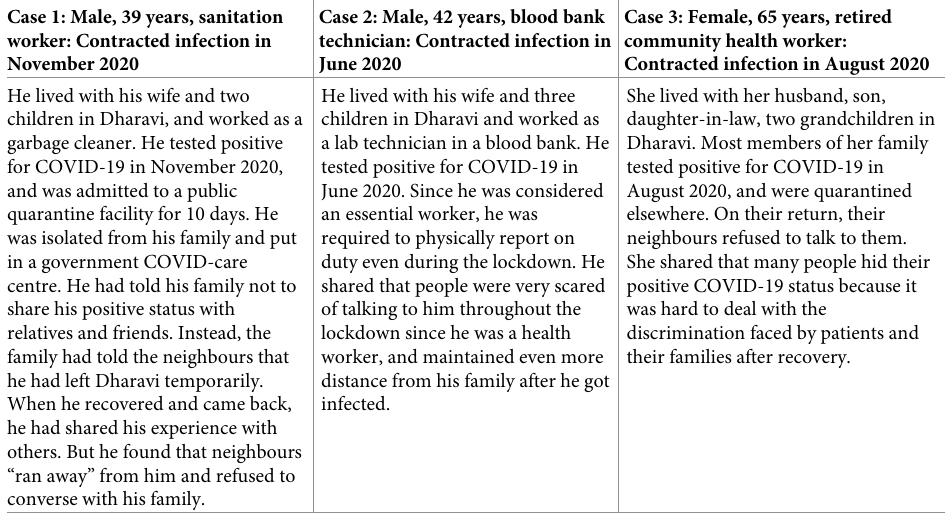
Table 8. Experiences of discrimination reported by